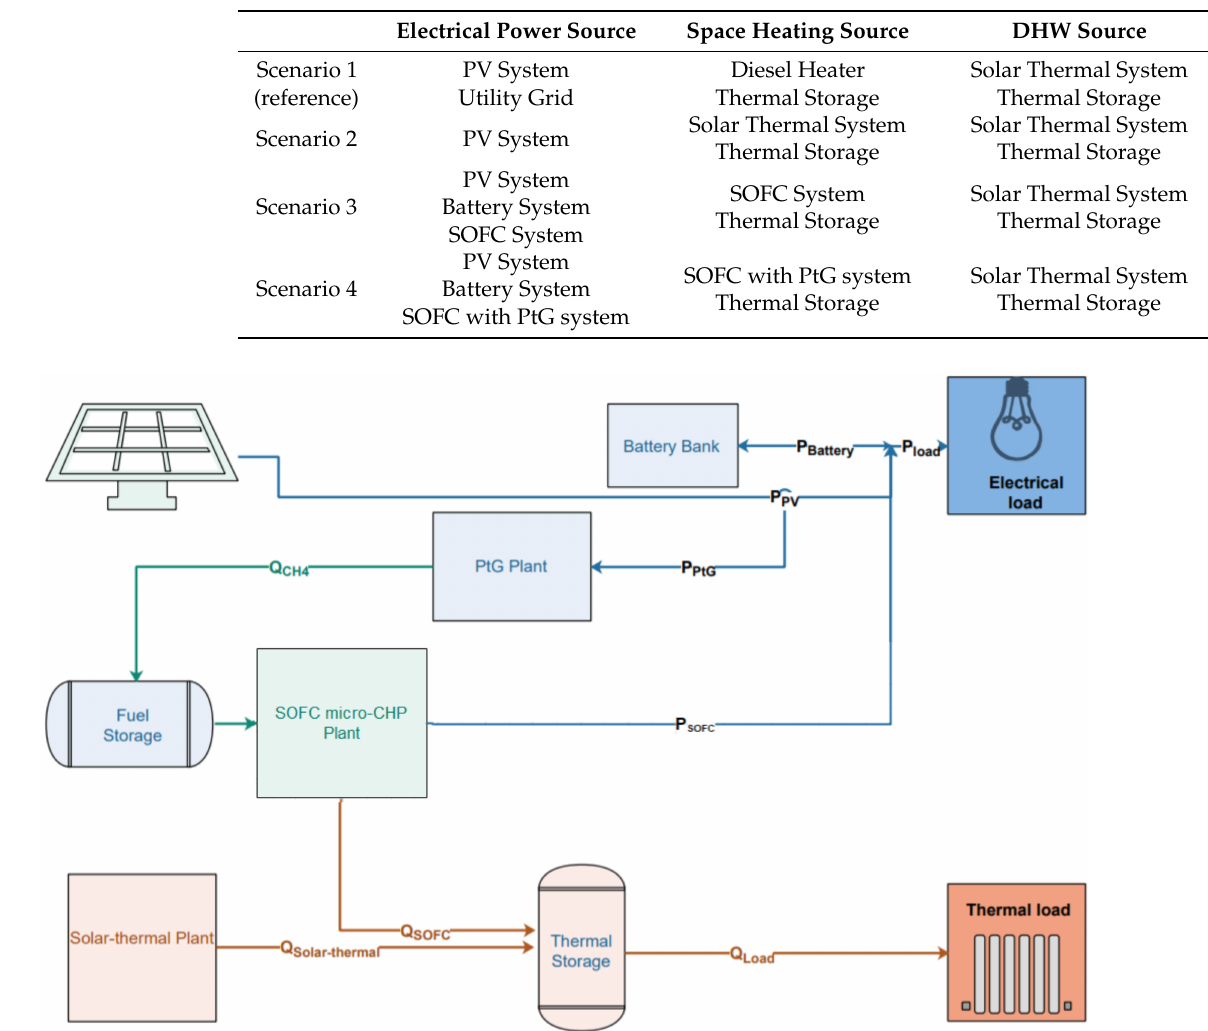
Table 7. The four different developed simulation scenarios representing the included plants in each scenario.